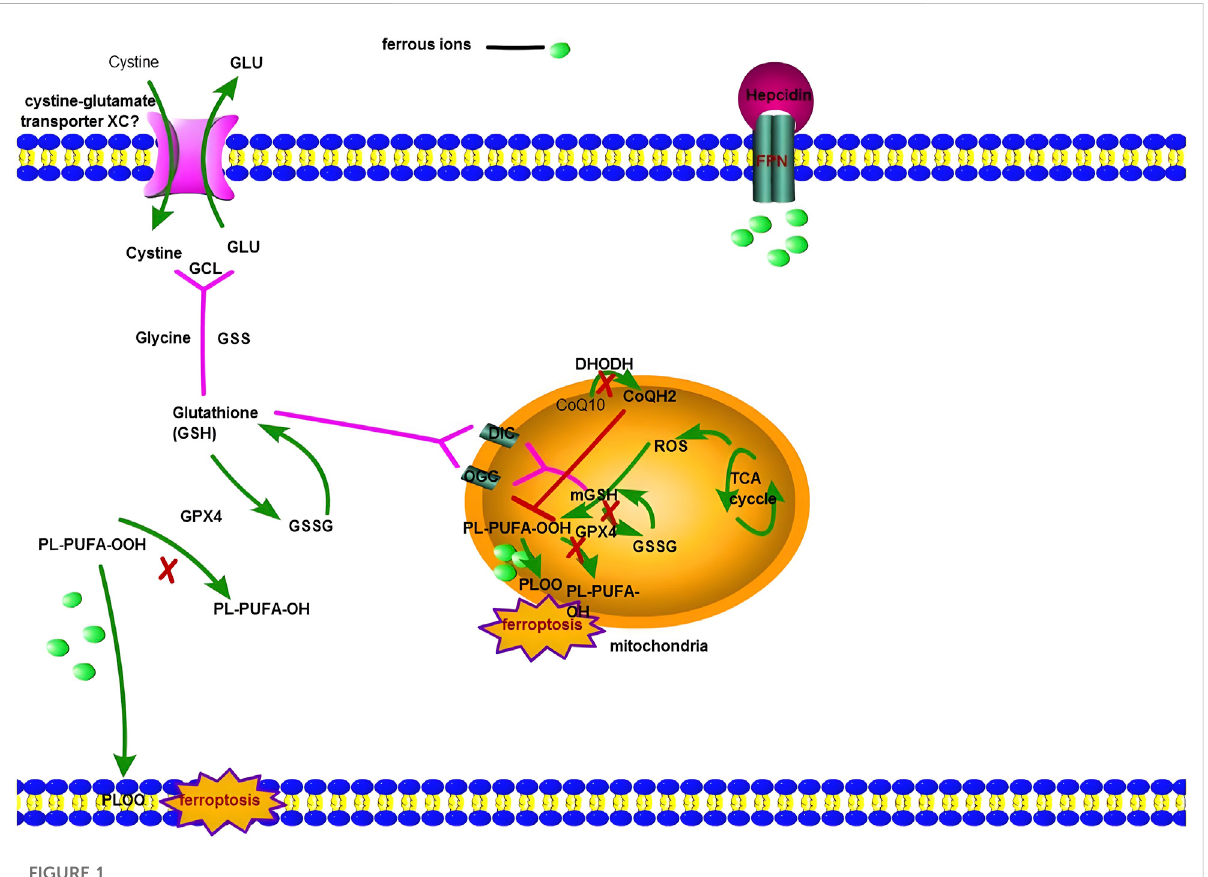
FIGURE 1 The fi gureshowsferroptosisinvolvesboththecytoplasmandmitochondria.Cystine-glutamatetransporterX C − isresponsibleforthetransferof Cystine into the macrophage (or hepatocytes around the portal vein), then Cysteine takes part in the process of Glutathione biosynthesis. GPX4 regulates the reduced state (GSH) and oxidized state (GSSH). Meanwhile, PL-PUFA-OOH is converted to PL-PUFA-OH by GPX4. When prolonged in fl ammation can produce more interleukin-6 (IL-6), and the binding of IL-6 to its receptor activates hepatocyte ’ s JAK/STAT pathway, resulting in STAT3 phosphorylation. Phosphorylated STAT3 enters the hepatocyte nucleus and activates the Hepcidin gene expression by locating the binding site in the Hepcidin promoter region. A large amount of Hepcidin protein is fi nally secreted out of the cells. It results in the combination of Hepcidin and FPN and leads to FPN degradation via ubiquitination and internalization, so macrophages (or hepatocytes around the portal vein) accumulate more iron. When GPX4 is deactivated, theFenton reaction caninitiate ferroptosis inthe cytoplasm. For NASH patients, there exists another mechanism: ferroptosis in mitochondria. Mitochondria have two kinds of antioxidase: GPX4 and DHODH. DHODH is located on the outside surface of the inner mitochondrial membrane. It can reduce coenzyme Q (CoQ) to ubiquinol (CoQH2). CoQ is a critical component in the electron transport chain. CoQH2 is the reduced form of CoQ; as an antioxidant, CoQH2 captures free radicals produced via lipid peroxidation. Hence, ferroptosis will start successfully in mitochondrial if DHODH and GPX4 are both